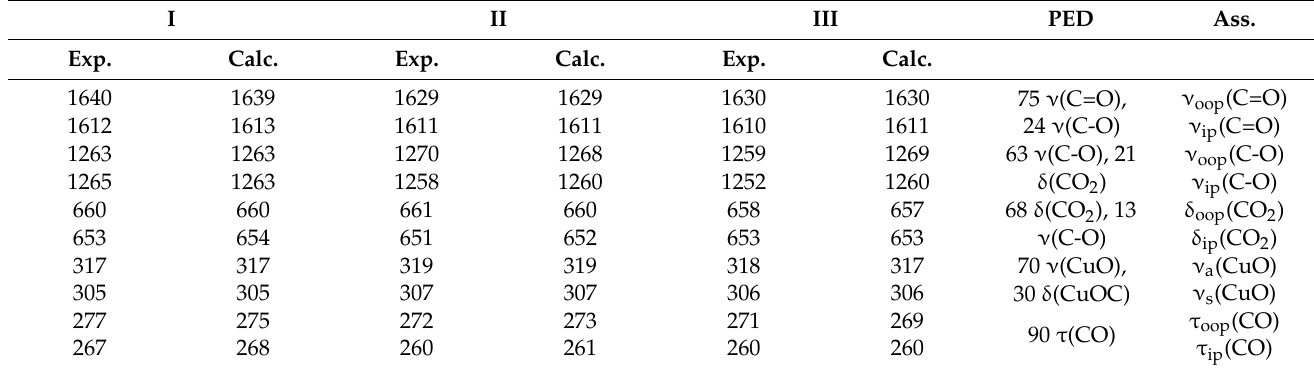
Table 3. Experimental and calculated vibrational frequencies (cm − 1 ) of carboxylate moieties together with potential energy distribution (%) in I – III .